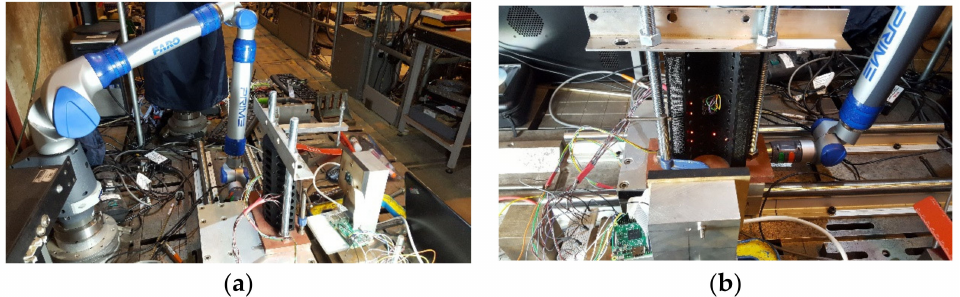
Figure 7. Optical tracking test setup: ( a ) Side view; ( b ) Front view.